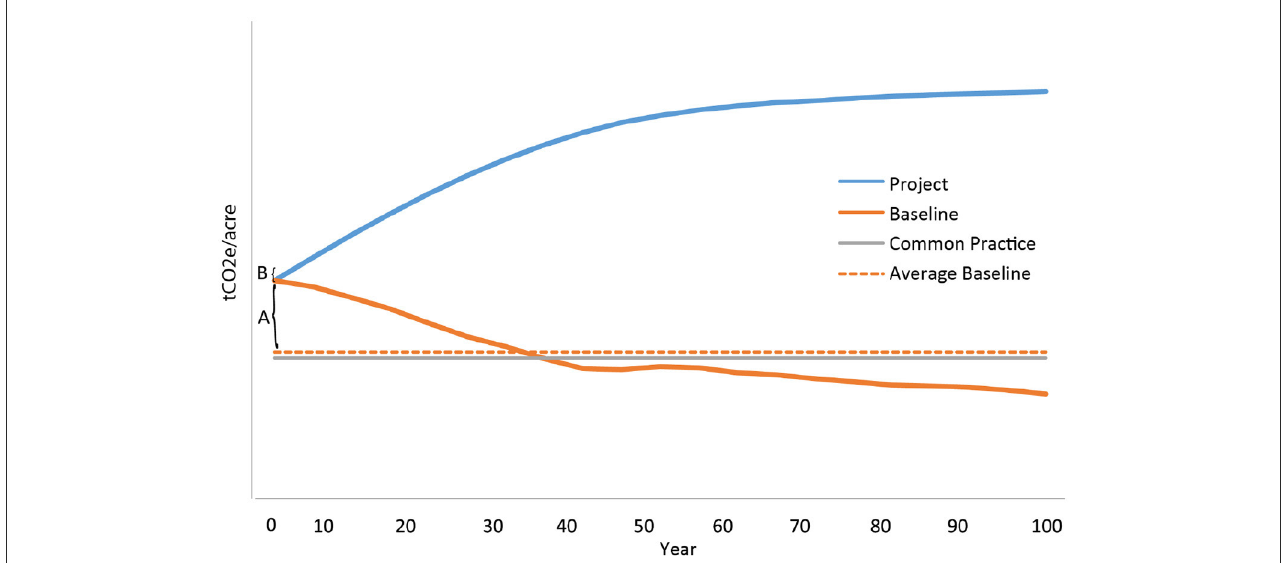
FIGURE2 A sample ARB project and baseline scenario based on a project in Oregon (ACR 260). The pattern shown is similar in many other IFM offset projects. “A” represents the credits generated in the 1st year of the project from the difference in actual onsite carbon stocks compared to the 100-year-average baseline. “B” represents the credits generated in years 2 through 5 of the project from forest